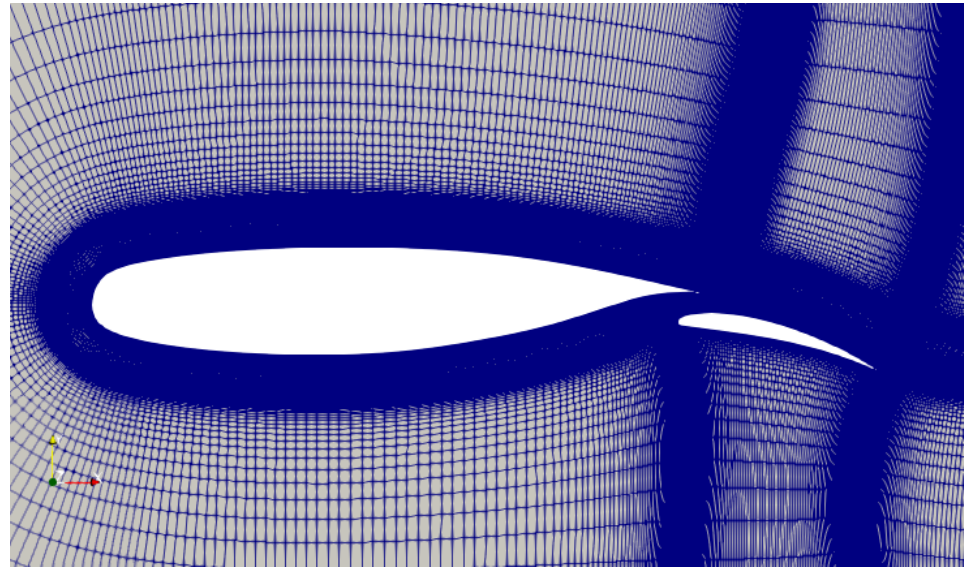
Figure 3. Mesh around NLR 7301 airfoil with trailing-edge